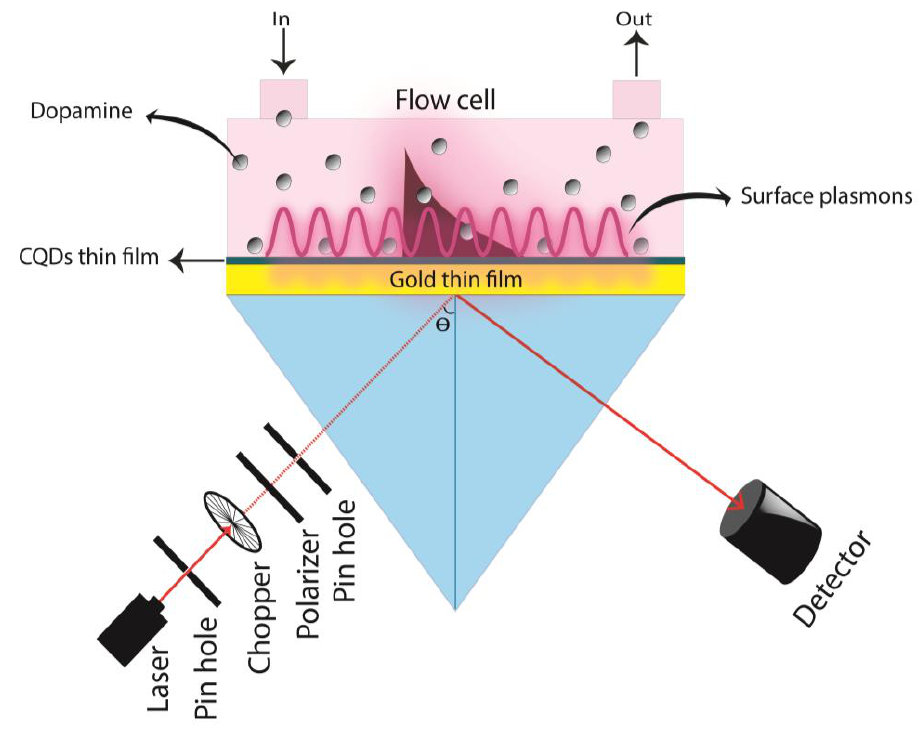
Figure 1. SPR configuration